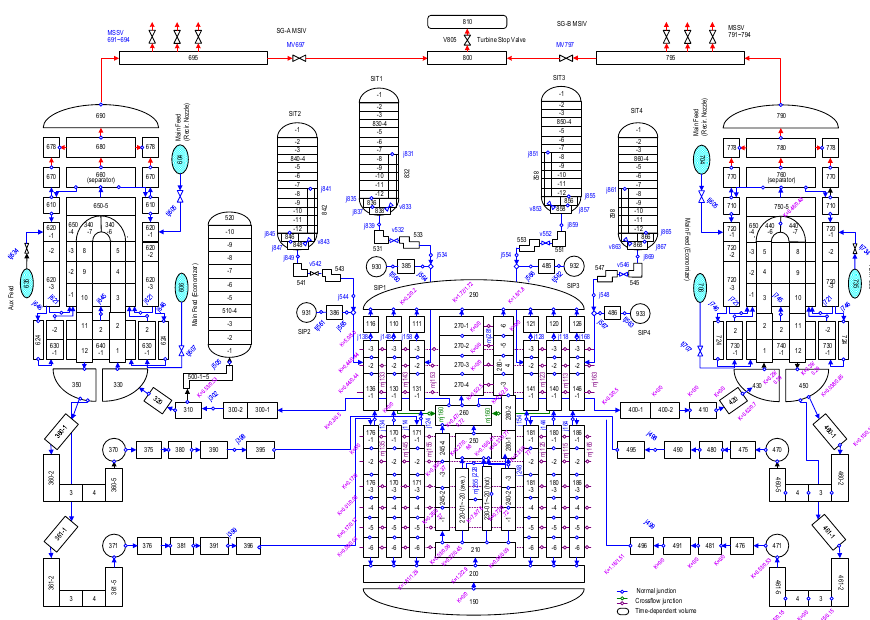
Figure 1. Nodalization of APR1400.